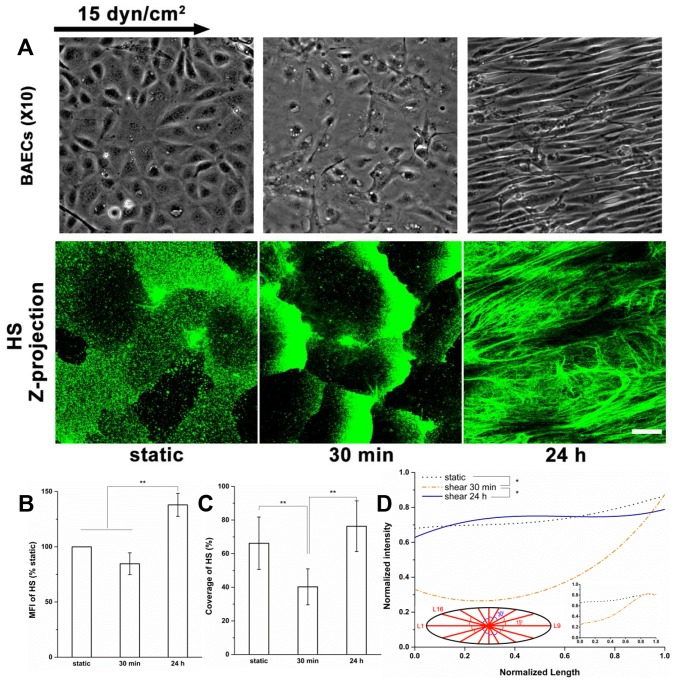
Validation of the clustering and subsequent restoration of HS under shear stress using bovine aortic endothelial cells.(A) Top: Phase contrast micrographs of confluent BAEC monolayer reveal a typical dynamic change in cell morphology from cobblestone (static control) to the elongated (fusiform) and oriented in the direction of flow. Bottom: Representative immunofluorescent images of HS under static and shear stress conditions. (B) MFI, (C) Coverage, and (D) Scattering distribution displays the average intensity along lines from the centroid to the boundary of cells (n = 10 cells). For each cell, 16 lines (D left insert) were selected to analyze the scattering distribution. We also showed the radial distributions (D right insert, plotted by normalized radius on the horizontal axis and normalized intensity on the vertical; n = 50 cells). No significant differences were found between radial distribution and scattering distribution at both static and 30 min (P>0.05) indicating the radial distribution is appropriate for cobblestone ECs. The clustering of HS at 30 min and restoring of HS at 24 h on BAECs are similar to the results on RFPECs showed in our previous [7] and the present study, respectively. Scale bar: 20 µm. *P<0.05; **P<0.01.